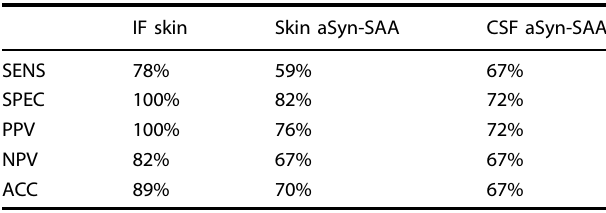
SENS sensitivity, SPEC speci fi city, PPV positive predictive value, NPV negative predictive value, ACC